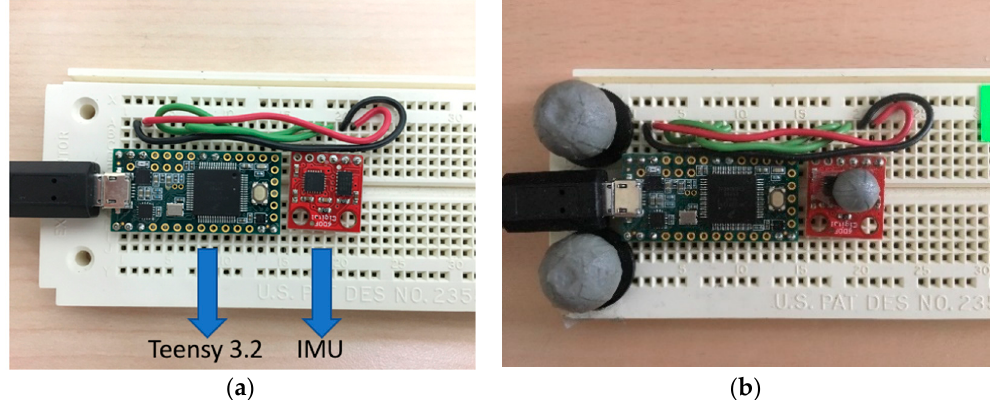
Figure 2. ( a ) Teensy 3.2 and Inertial Measurement Unit (IMU) connected on a breadboard; ( b ) Teensy 3.2 and IMU connected on a breadboard with motion capture markers.